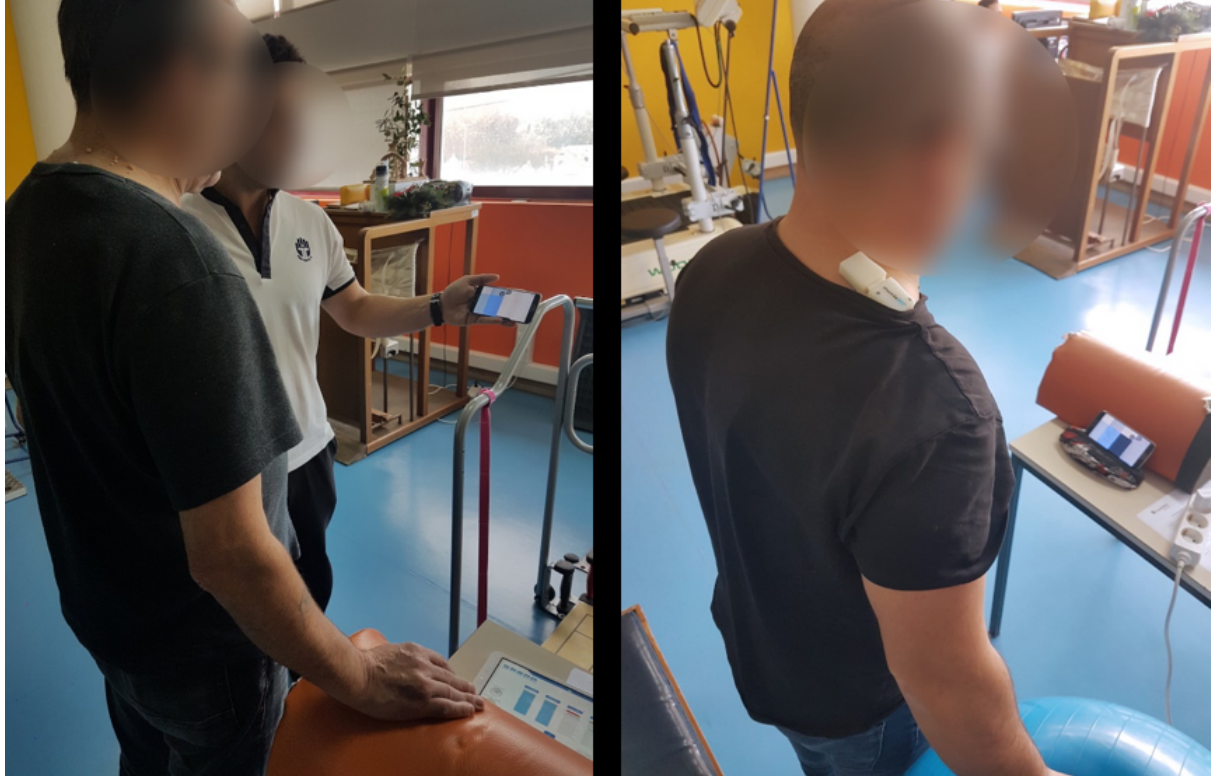
Figure 4. Patient playing the eleRehab serious game with a smartphone and two sensors worn on the back to monitor exercises. Notice the table, Pilates ball, and other materials supporting exercise execution and the active role of the physiotherapist in supporting the patient in playing the serious